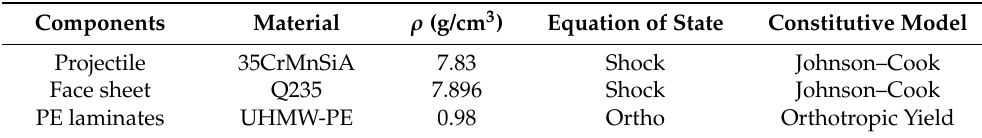
Figure 3. Grid and numerical models of armor impacted by blunt projectile. ( a ) Armor with two layers of UHMW-PE. ( b ) Armor with three layers of UHMW-PE. of UHMW-PE. ( b ) Armor with three layers of UHMW-PE. Table 2. Material models used in numerical simulation. Table 2. Material models used in numerical simulation.